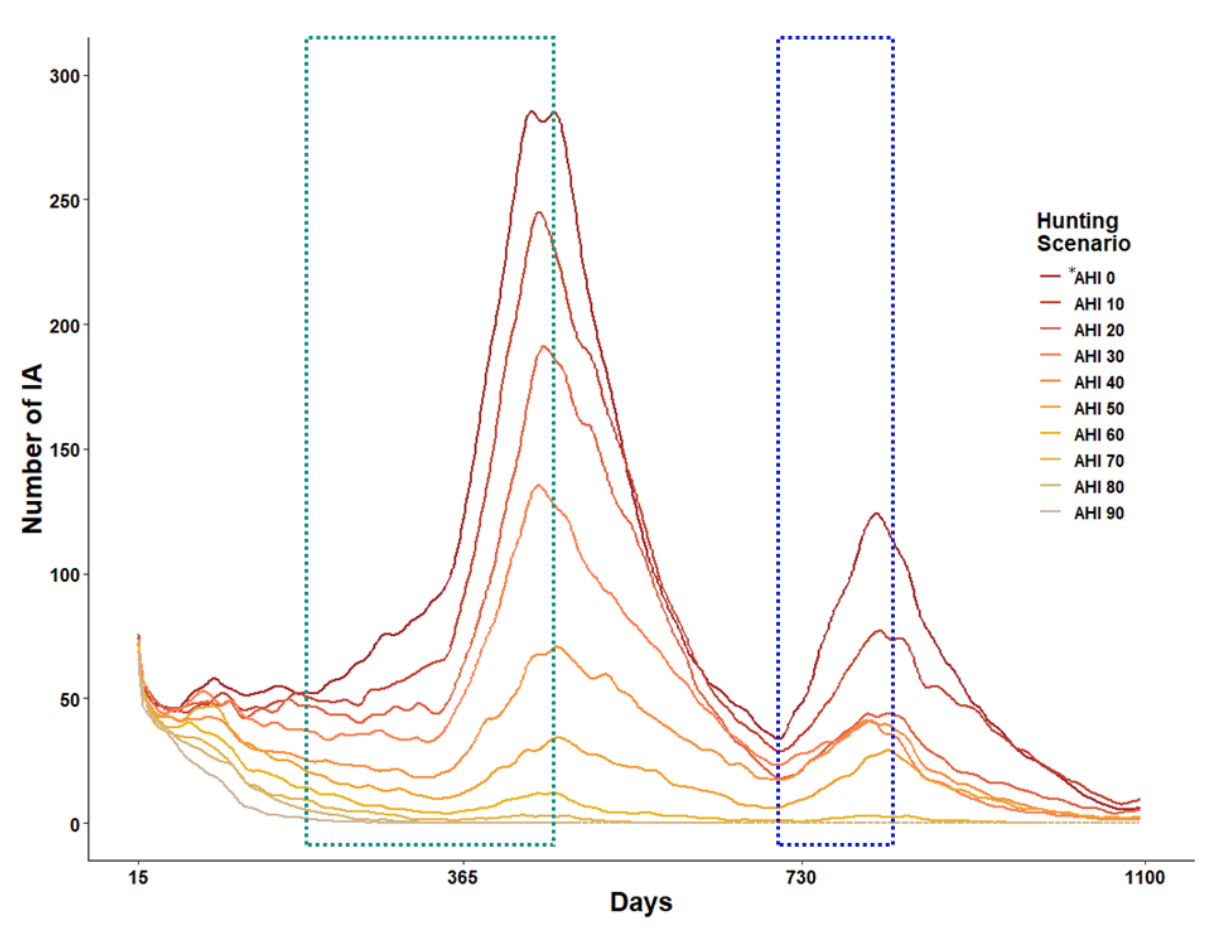
Figure 6. The number of IA changes in the three years simulation period depends on hunting intensity scenarios. The green and blue dash boxes represent the first and second reproduction periods of NIA. * AHI represents annual hunting intensity.